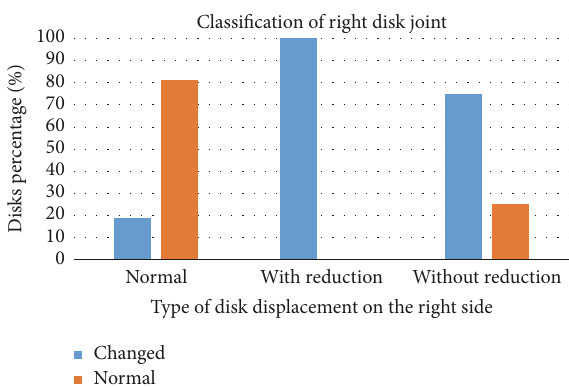
Figure 7: Association between disk classification and disc classifi- cation on the right side.